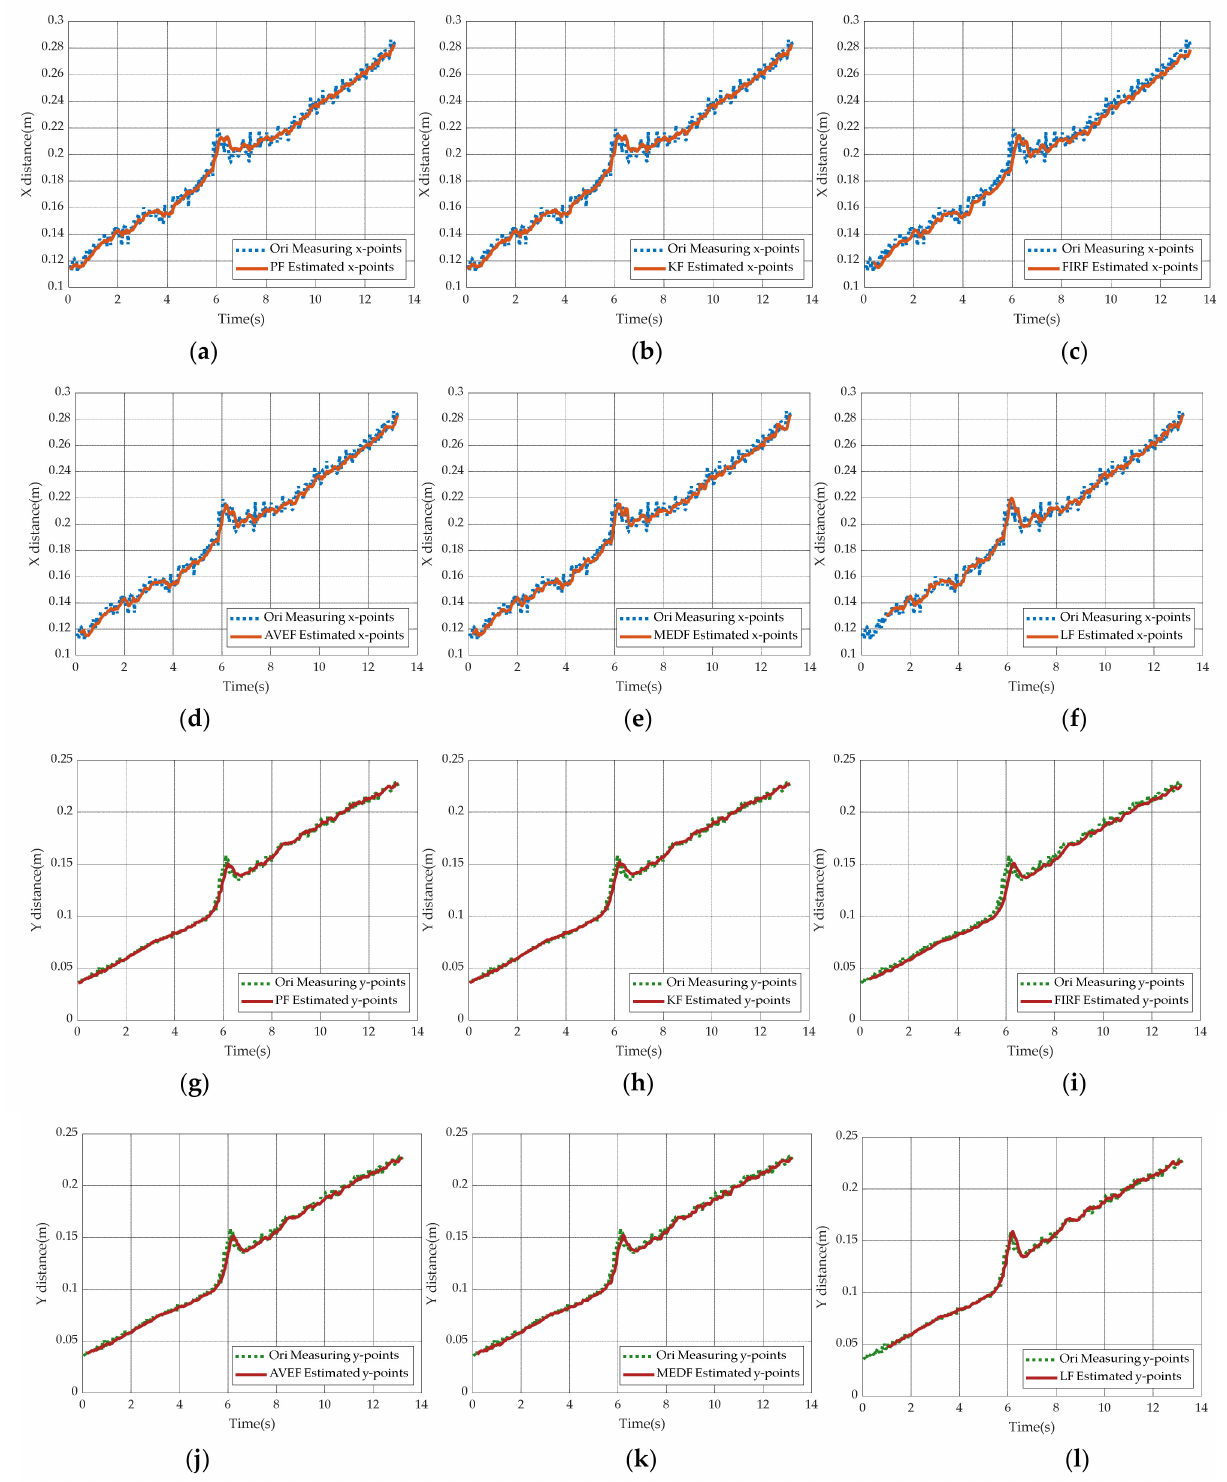
Figure 11. Comparison of the filter effect of different filters under nonlinear conditions on the x-axis and y-axis: ( a ) is the effect of PF on the x-axis direction; ( b ) is the effect of Kalman filter (KF) on the x-axis direction; ( c ) is the effect of finite impulse response filter (FIRF) on the x-axis direction; ( d ) is the effect of average filter (AVEF) on the x-axis direction; ( e ) is the effect of median filter (MEDF) on the x-axis direction; ( f ) is the effect of linear fit filter (LF) on the x-axis direction; ( g ) is the effect of PF on the y-axis direction; ( h ) is the effect of KF on the y-axis direction; ( i ) is the effect of FIRF on the y-axis direction; ( j ) is the effect of AVEF on the y-axis direction; ( k ) is the effect of MEDF on the y-axis direction; ( l ) is the effect of LF on the y-axis